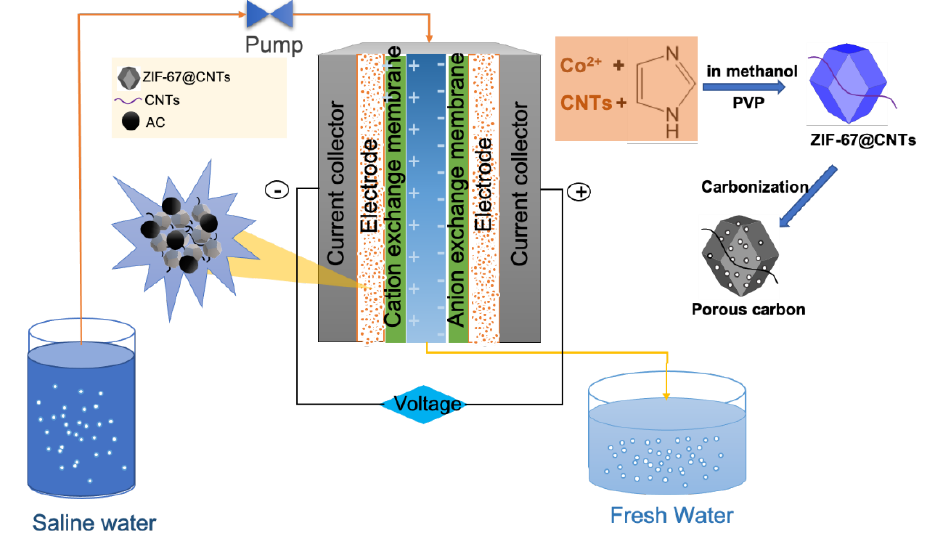
Figure 1. Schematics of capacitive deionization (CDI) desalination system using ZIF-67@CNTs as electrodes.